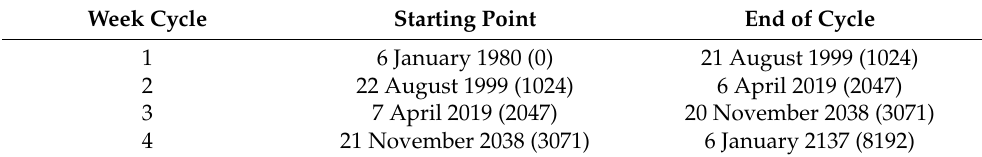
Table 1. GPS week number rollover epoch occurrences starting from the first lunch of GPS system.